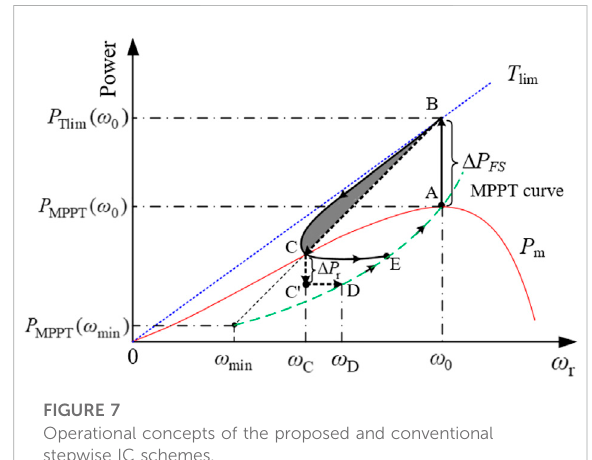
Operational concepts of the proposed and conventional stepwise IC